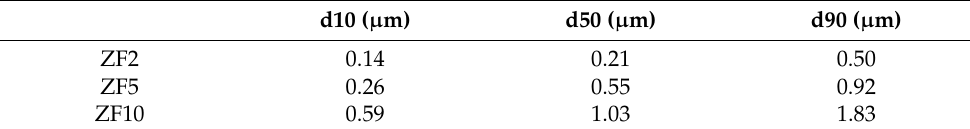
Table 1. Detailed particle size distributions of yttria-stabilized zirconia.